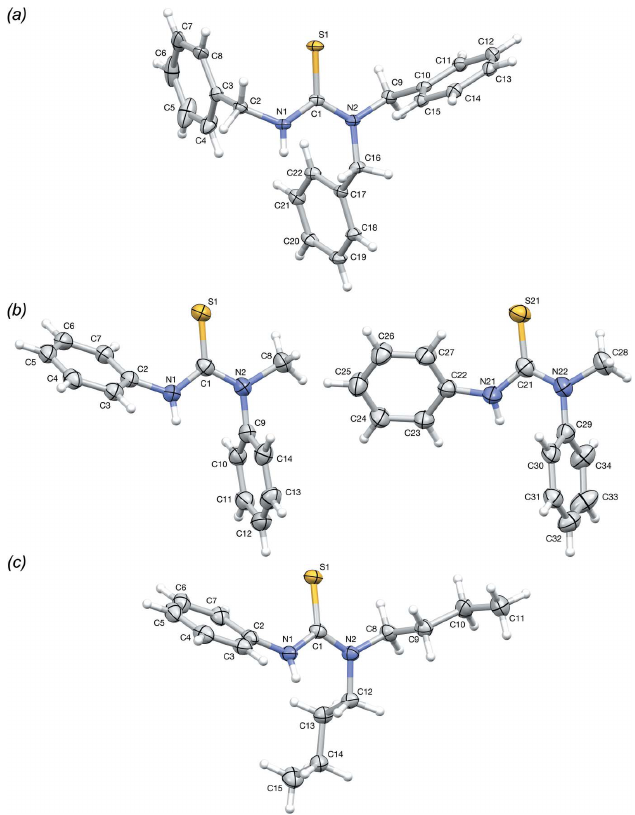
Figure 1 Molecular structures of ( a ) 1 , ( b ) 2 and ( c ) 3 , showing thermal displacement ellipsoids drawn at the 50% probability level and the atom-labelling scheme for the non-hydrogen atoms. For 2 , both molecules of the asymmetric unit are